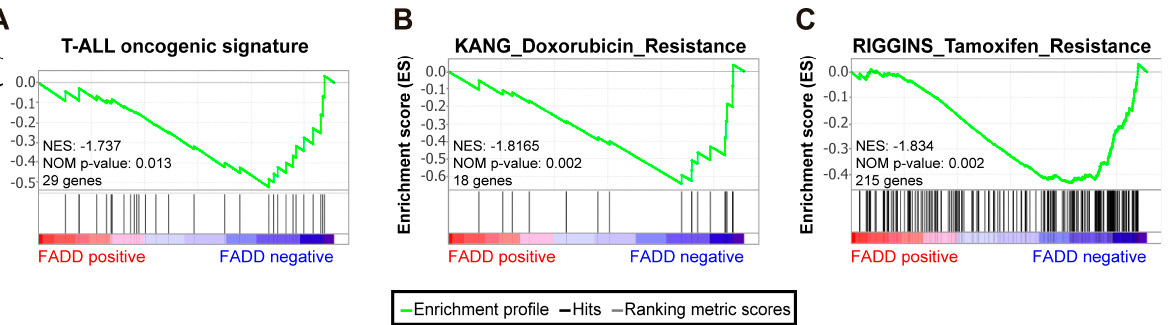
Figure 2. The FADD-negative phenotype showed a significant association with oncogenic signatures. Gene Set Enrichment Analysis was performed in 264 patients with precursor T-cell neoplasm, based on their FADD expression levels, which defined FADD-negative and FADD-positive phenotypes. These signatures were significantly enriched in the FADD-negative phenotype. ( A ) This signature was created ad hoc based on previous literature and is defined in Supplementary Table S1. ( B , C ) These signatures were selected from the Molecular Signatures Database, and their systematic names are M3323 (Doxorubicin Resistance) and M15835 (Tamoxifen Resistance). The green curve corresponds to the enrichment score (ES) curve, which is the running sum of the weighted enrichment score obtained with the GSEA software. NES, normalized enrichment score; p , nominal p value.